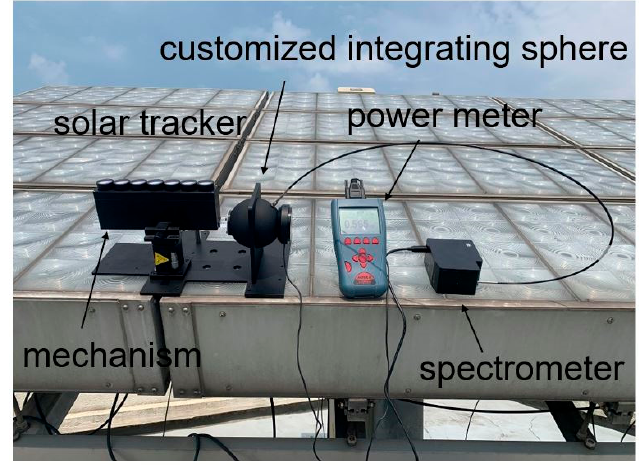
Figure 7. Assembled module with the measuring instruments allocated on the solar tracker.